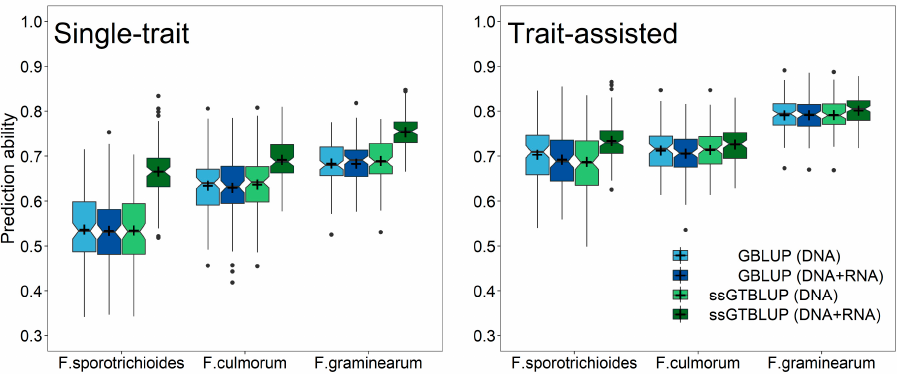
Figure 4. Prediction ability for resistance against three tested Fusarium isolates using single-step genomic-transcriptomic prediction (ssGTBLUP) within the groups of RNA-sequenced (dark green) and non-RNA-sequenced genotypes (light green) as well as genomic prediction (GBLUP) within the group of RNA-sequenced (dark blue) and non-RNA-sequenced genotypes (light blue). Result are shown for the single-trait predictions (left) and the trait-assisted prediction with exploiting pre-existing information about anther retention (right). The presented results are based on a split with half of the genotypes being part of RNA-sequenced and the other half of the non-RNA-sequenced group.